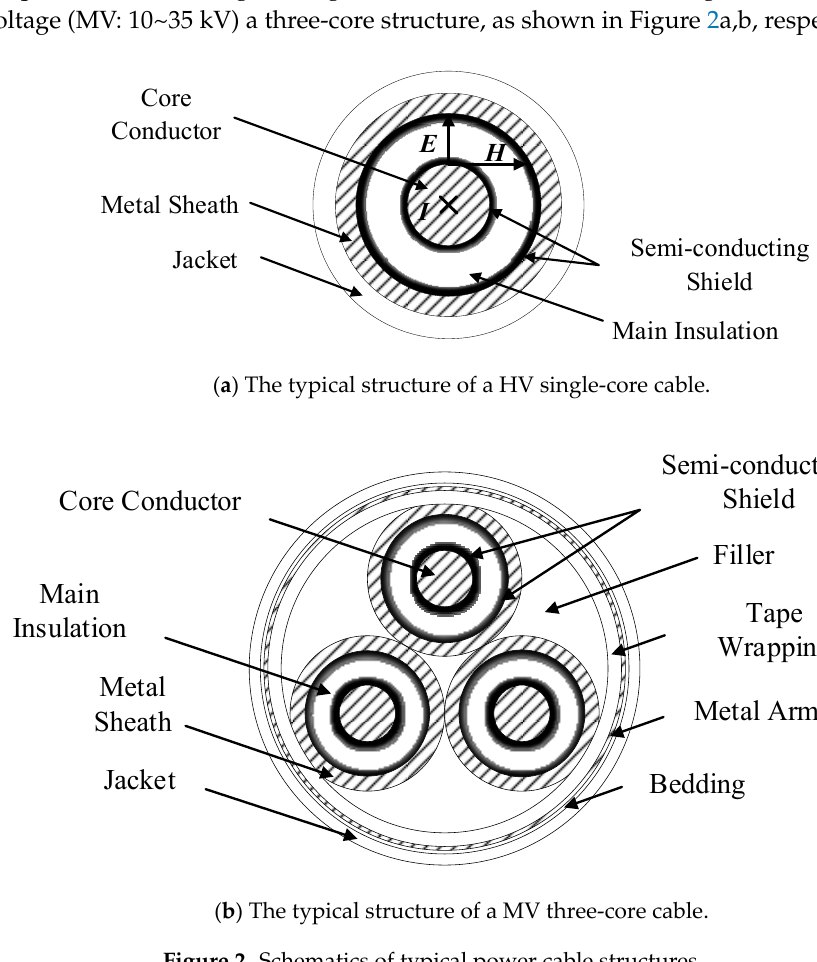
Figure 2. Schematics of typical power cable structures.